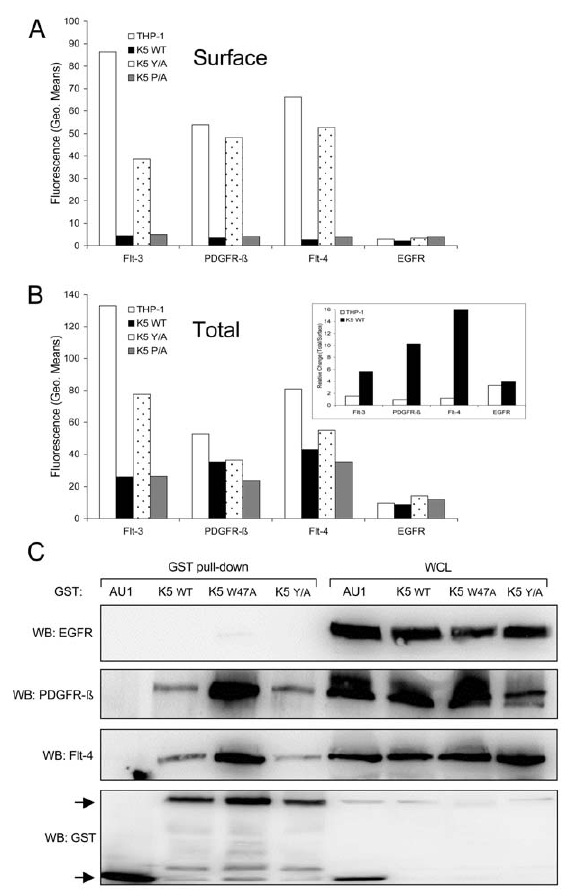
Figure 7. K5 interacts with and alters RTK localization. Equal cell numbers of the indicated THP-1 lines were fixed with paraformaldehyde (PFA) and ( A ) stained without permeabilization to determine surface expression or ( B ) permeabilized with saponin prior to staining to determine total expression of Flt-4, PDGFR-ß, Flt-3 and EGFR by flow cytometry. Data are representative of three independent experiments. ( B, Inset ) The relative ratio of surface versus total RTKs was determined for vector- and K5 WT-expressing THP-1 cells. ( C ) 293T cells were co- transfected with expression constructs for EGFR, PDGFR-ß, or Flt-4 and the indicated GST expression constructs. After two days, lysates were subjected to GST pull-down using glutathione-sepharose beads. Purified proteins and whole cell lysates (WCL) were subjected to western blot (WB) using anti-EGFR, -Flt-4 or -PDGFR-ß antibodies, followed by re-probing with anti-GST antibodies. Arrows indicate GST or GST-K5 WT and mutant specific bands. Data are representative of three independent